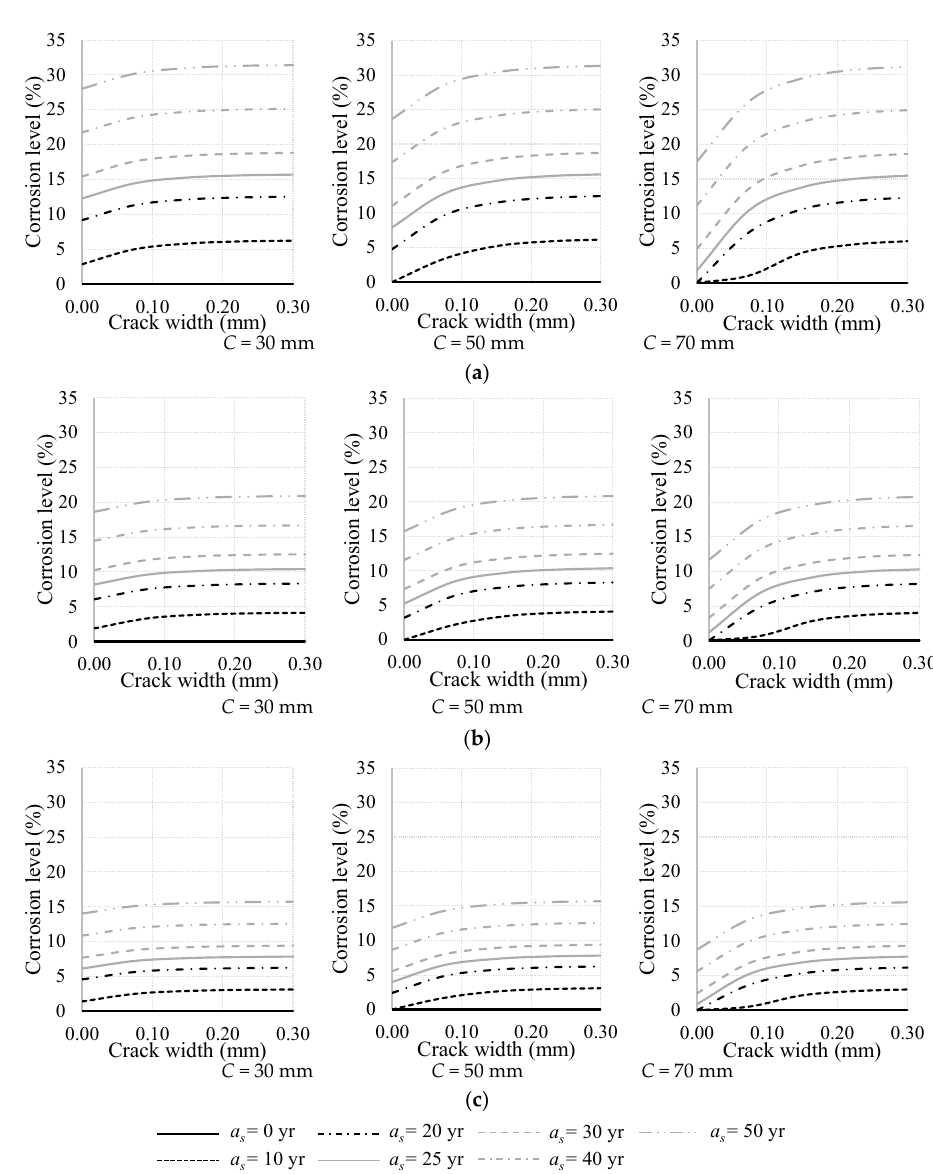
Figure 11. Serviceability life in reinforced concrete sections: ( a ) ϕ = 12.7 mm; ( b ) ϕ = 19.1 mm; ( c ) ϕ = 25.4 mm.